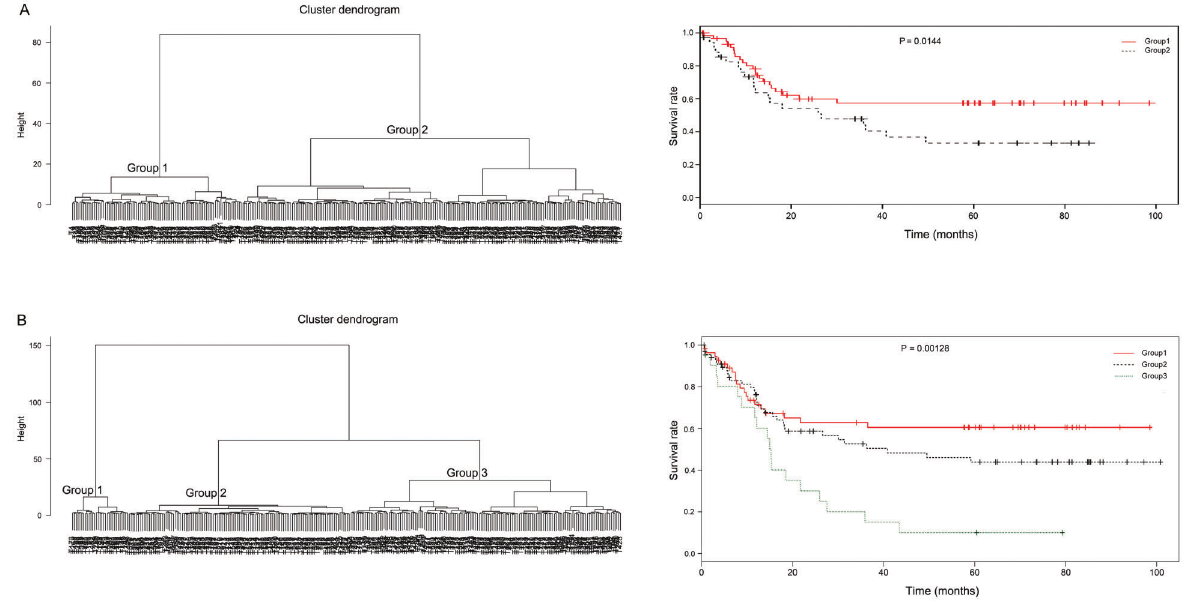
Figure 7. Clustering of gastric cancer samples in GSE62254 dataset based on genes in yellow ( A ) and turquoise ( B )